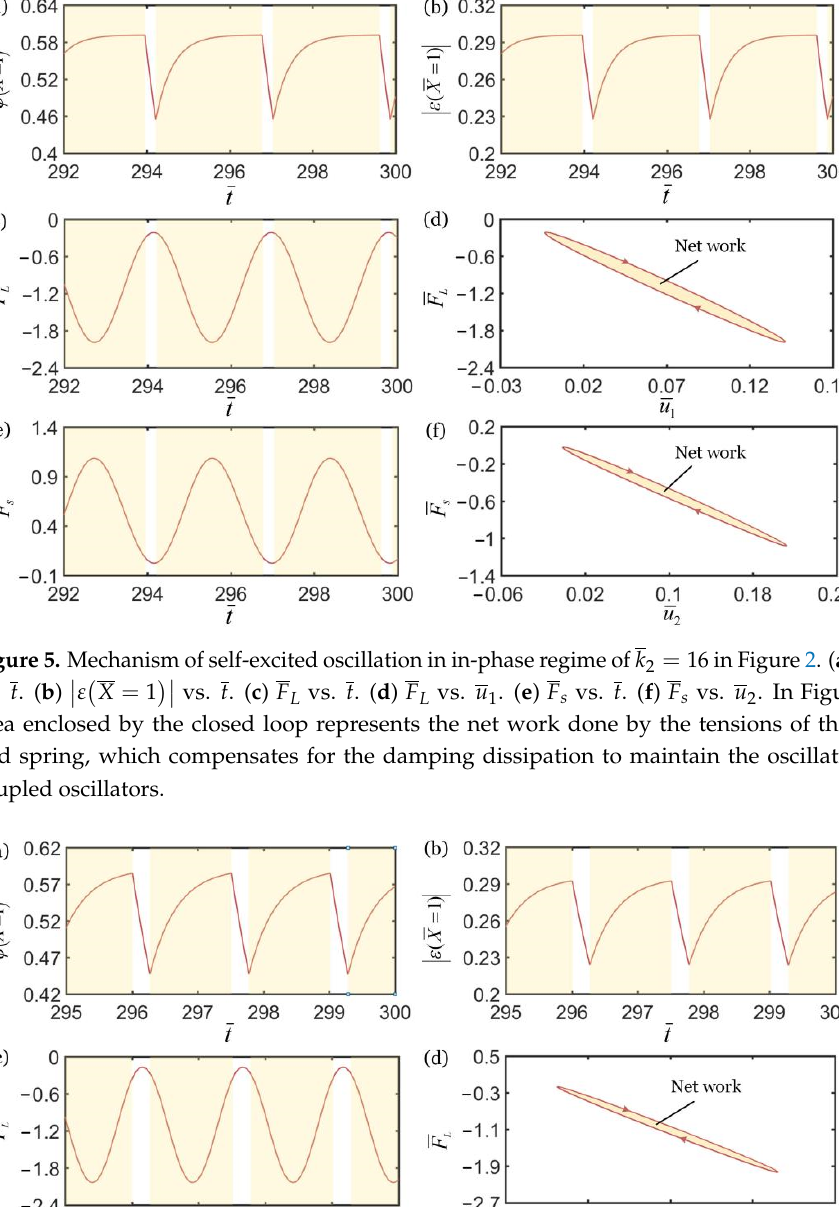
= k 5.4 in Figure 3. ( a ) 2 vs.